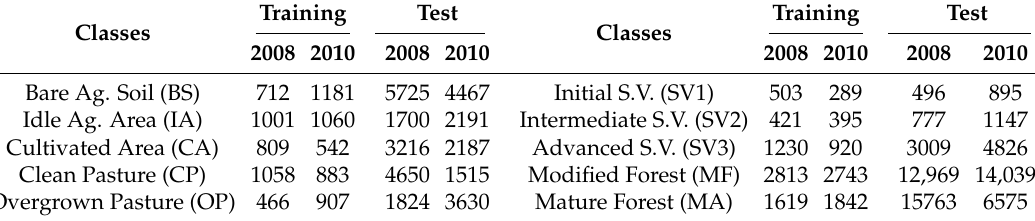
Figure 3. Labeled samples for land cover classes over band 5 of LANDSAT5/TM images acquired in 23 June 2008 (2008 samples) and 29 June 2010 (2010